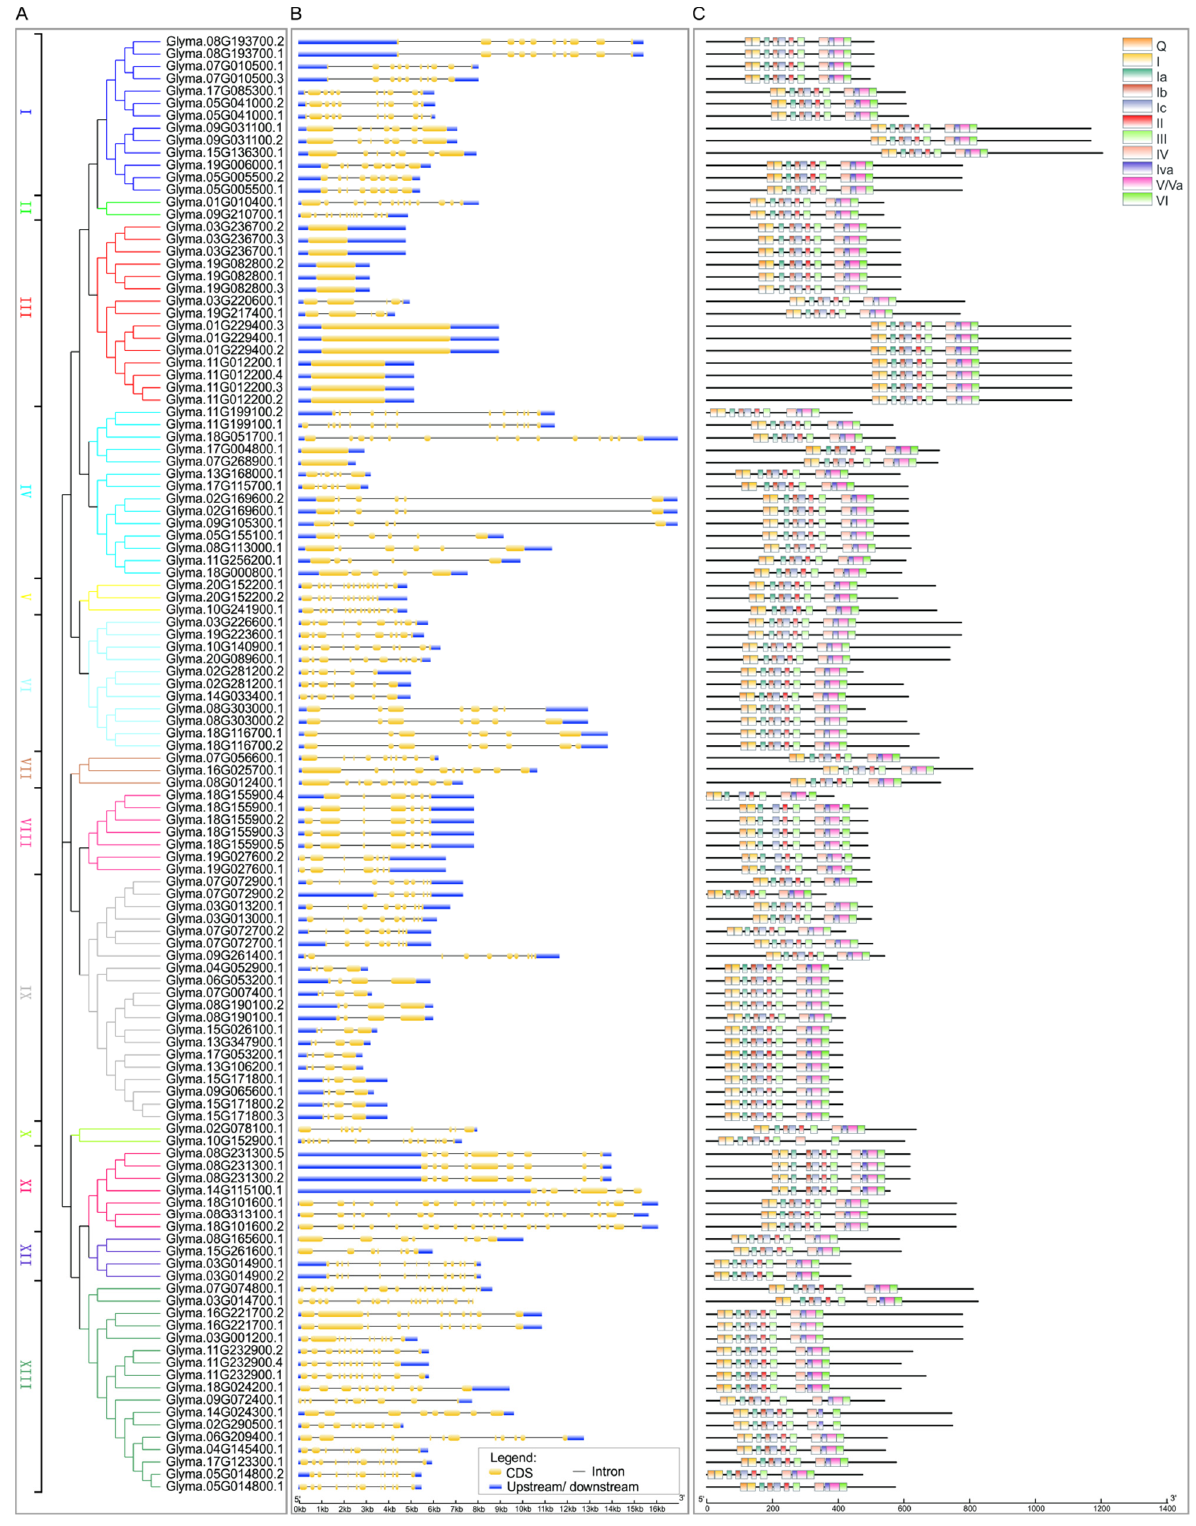
Figure 3. The structures and motif compositions of DDX genes and proteins. ( A ) Phylogenetic tree and classification of DDX proteins was constructed by MEGA. ( B ) Gene structures of DDX genes. The yellow boxes, black lines and blue boxes represent the CDS, intron and upstream/downstream. ( C ) Twelve conserved motif compositions of DDX proteins were identified using MEME. Each color represents a specific motif.